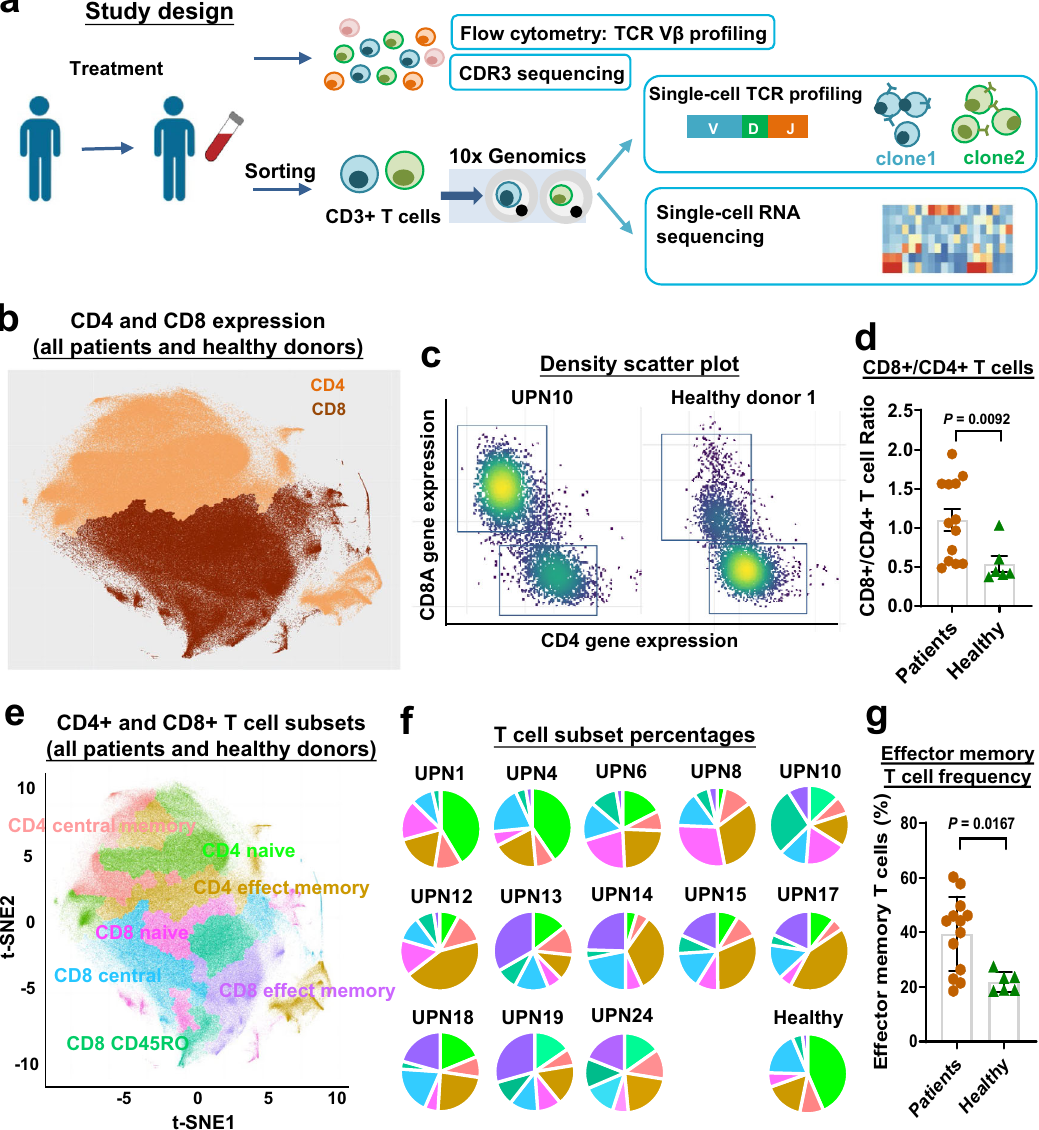
Fig. 1 A T cell landscape in T-LGLL patients. a A scheme of experimental study design. b A t-distributed Stochastic Neighbor Embedding (t-SNE) plot of single-cell gene expression of T cells in all patients and healthy donors, colored by CD4 + and CD8 + T cell clusters. c Density scatter plots of CD4 and CD8A expression in T cells, generated using scRNA-seq results. x -axis, CD4 gene expression; y -axis, CD8A gene expression; dots were colored by cell density. d A CD8 + /CD4 + T cell ratio was compared between patients ( n = 13) and healthy donors ( n = 6). Data are presented as mean values ± SEM; two- sided unpaired Mann – Whitney test. P value = 0.0092. e The same t-SNE plot in ( b ), color coded for CD4 + and CD8 + T cell subsets. f Pie charts showing percentages of T cell subsets in individual patients and healthy donors; color scheme as in ( e ). g Percentages of effector memory T cells were compared to patients ( n = 13) and healthy donors ( n = 6). Data are presented as mean values ± SEM; two-sided unpaired Mann – Whitney test, P value =